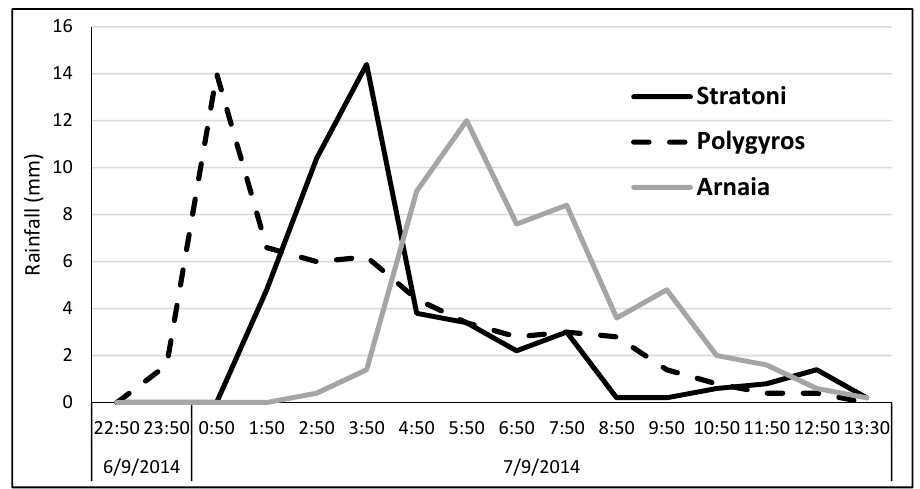
Figure 5. Rainfall intensity at Stratoni, Polygyros, and Arnaia observatories during the February 2010 flood event.